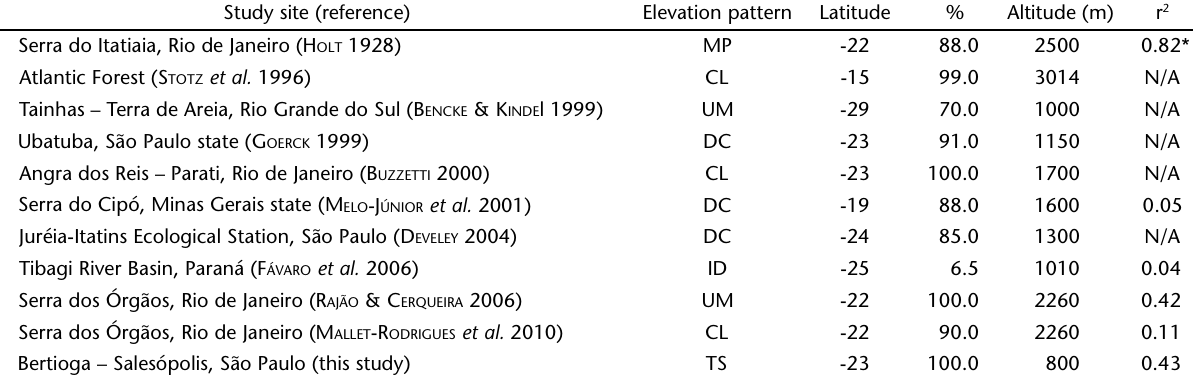
Table I. List of elevational gradients of bird species richness for the Atlantic Forest, Brazil. Richness pattern, latitude, percentage of gradient sampled, altitude and MDE null model r 2 values are given. N/A indicates studies with insufficient data for MDE analyses. (DC) Monotonic decreasing diversity, (CL) constant at low elevations, (UM) unimodal maximum at mid-elevations, (TS) trough-shaped, (ID) increasing